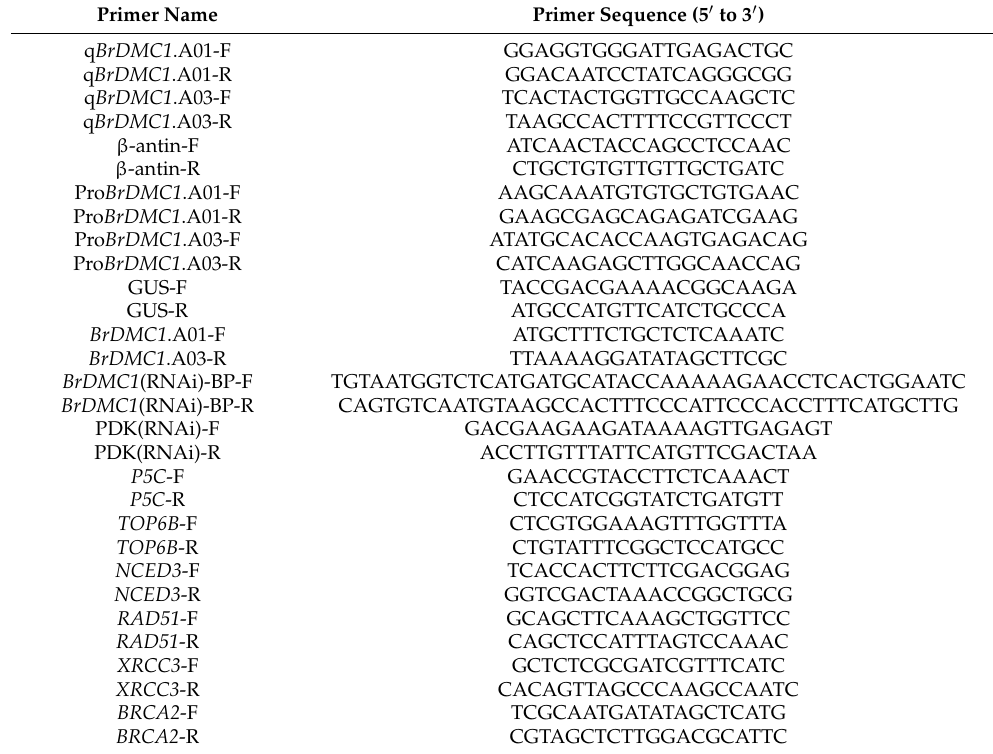
Table A1. Information of primer